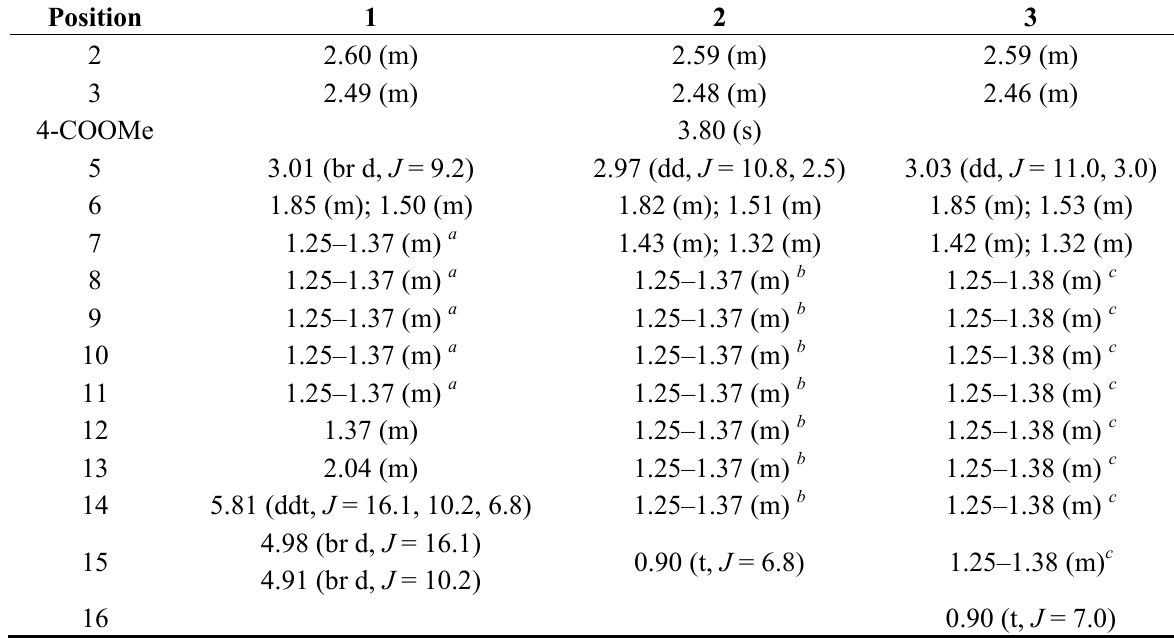
OD) of compounds 1 – 3 . 3